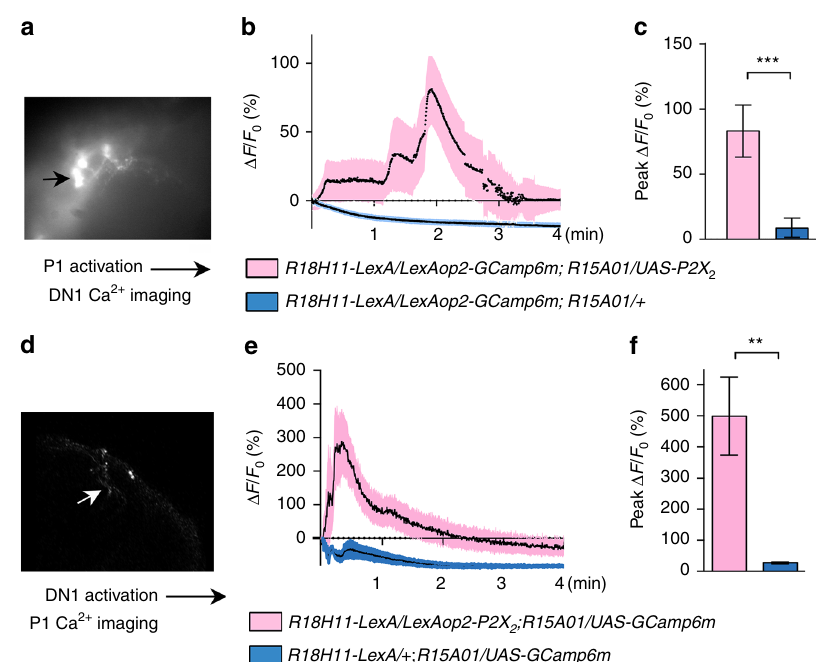
Fig. 6 P1 and DN1 neurons form mutually excitatory connections. a Movie still of Calcium imaging of DN1 cell bodies after P1 activation via P2X 2 . b Averaged traces of Δ F / F 0 of DN1 neurons after P1 activation. c Peak fl uorescence changes ( Δ F / F 0 ) of DN1 neurons after P1 activation. n = 6 for each, *** p < 0.001. Unpaired t- test. d Movie still of calcium imaging of P1 neurites in the lateral protocerebrum region after DN1 activation via P2X 2 . e Averaged traces of Δ F / F 0 of P1 neurons after DN1 activation. f Peak fl uorescence changes ( Δ F / F 0 ) of P1 neurons after DN1 activation. n = 10 for each, ** p < 0.01. Unpaired t- test. Error bars indicate